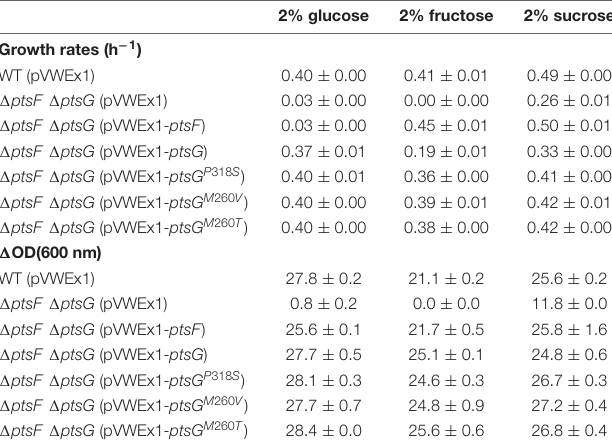
TABLE 3 | Growth rates and changes in OD (600 nm) during growth of recombinant strains on 2% glucose, 2% fructose, or 2% sucrose. 2% glucose 2% fructose 2% sucrose Growth rates (h − 1